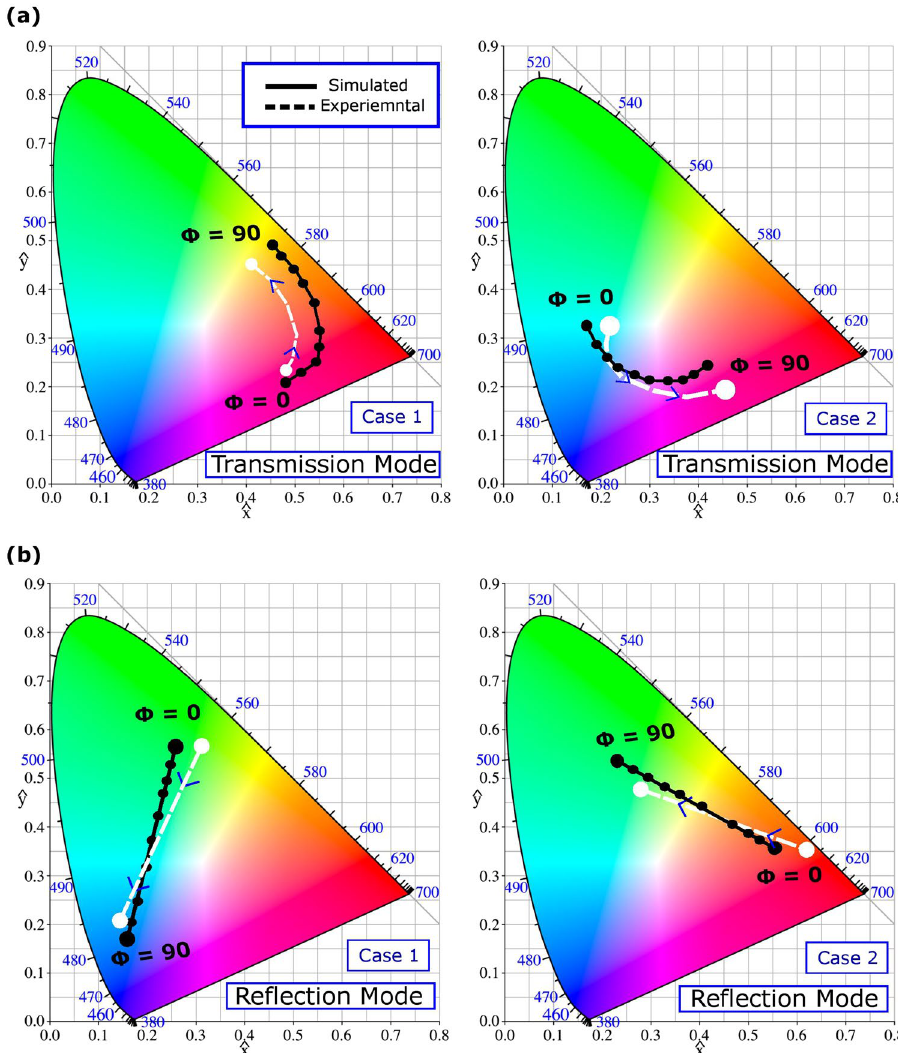
Figure 7. Polarization related changes in color: ( a ) for transmission mode, from magenta to yellow in Case 1 and from cyan to magenta in Case 2. ( b ) For reflection mode, from green to blue in Case 1 and from red to green in Case 2. Polarization angle of incident white light ( Φ ) is switched for experimental results from 0° to 90°; simulation results for polarization states, which correspond to Φ varied from 0° to 90° with the step ΔΦ = 10°, are shown for comparison. Blue numbers indicate wavelengths in nm for the ideal